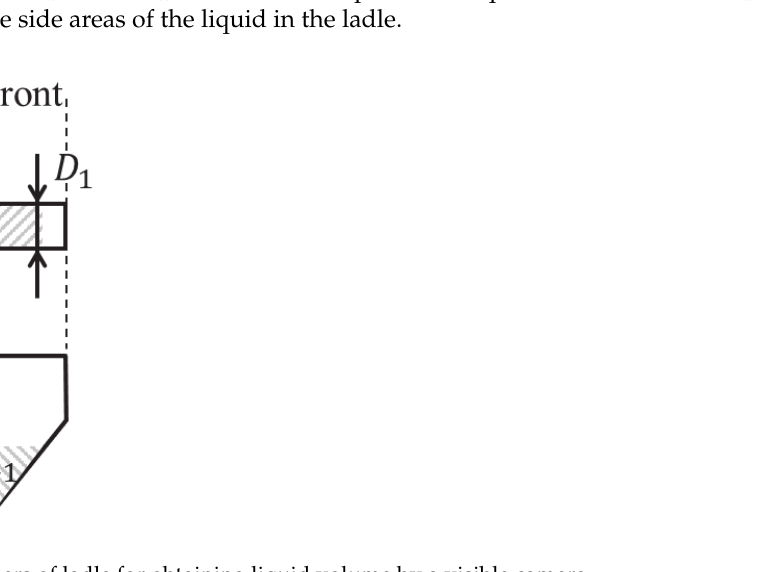
Figure 15. Parameters of ladle for obtaining liquid volume by a visible